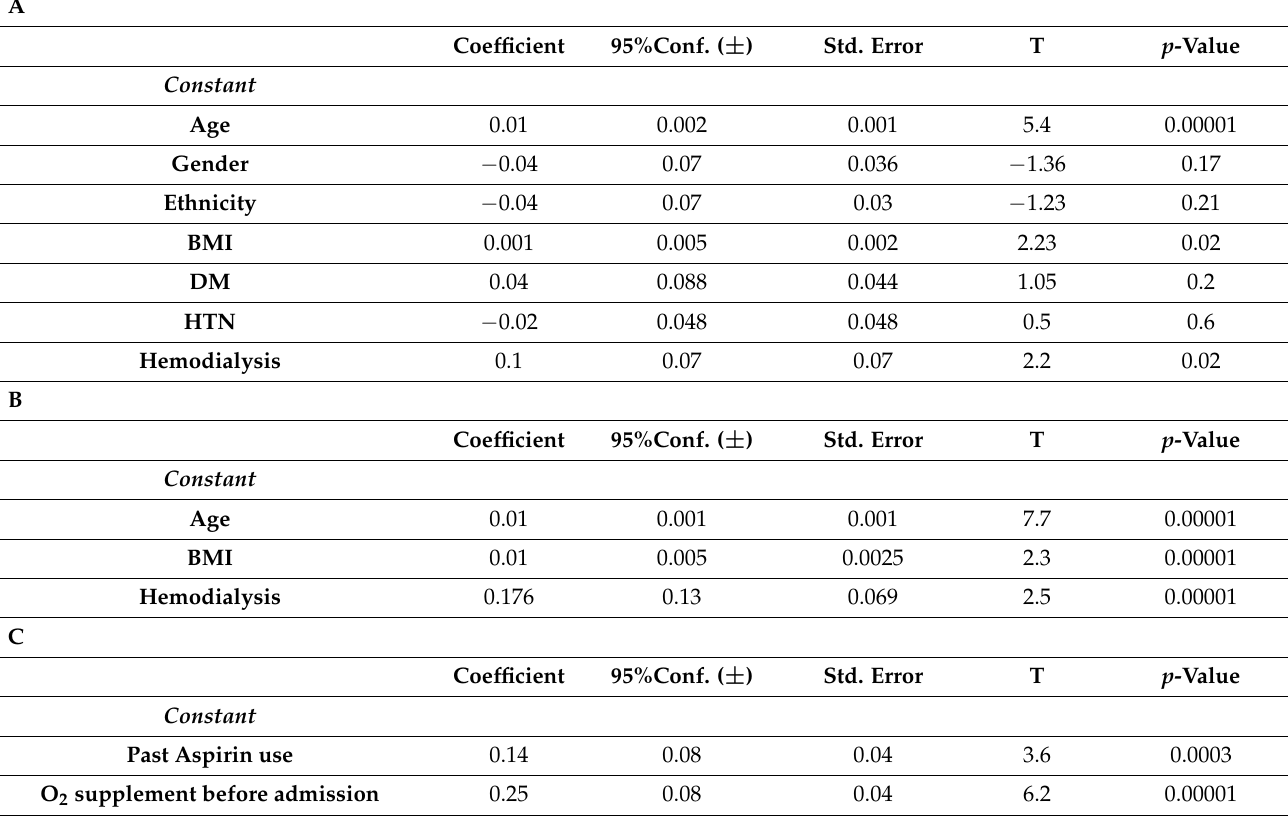
Table 2. Correlations between risk factors and mortality in COVID-19 patients. ( A ): Univariate analysis of the strength of risk factors in mortality prediction. ( B ): Multiregression analysis of risk factors. ( C ): Analysis of past medical history of the patients and mortality